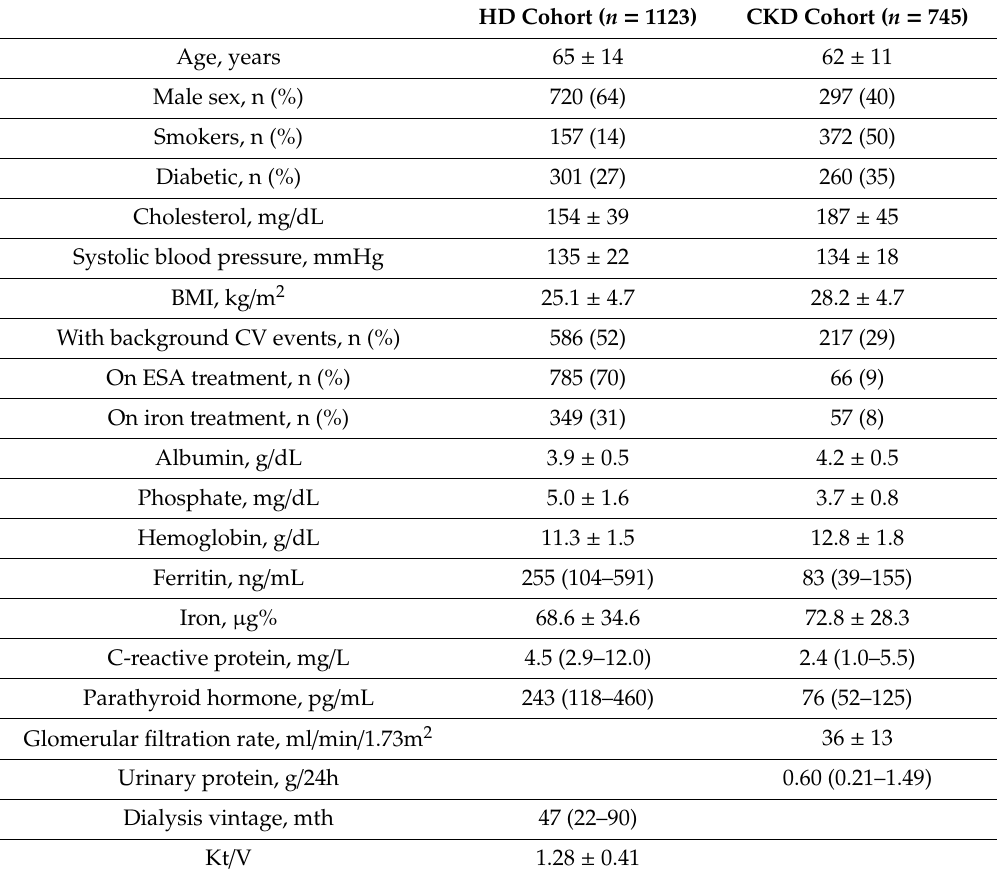
Table 1. Main demographic, somatometric, clinical, and biochemical characteristics of the two study